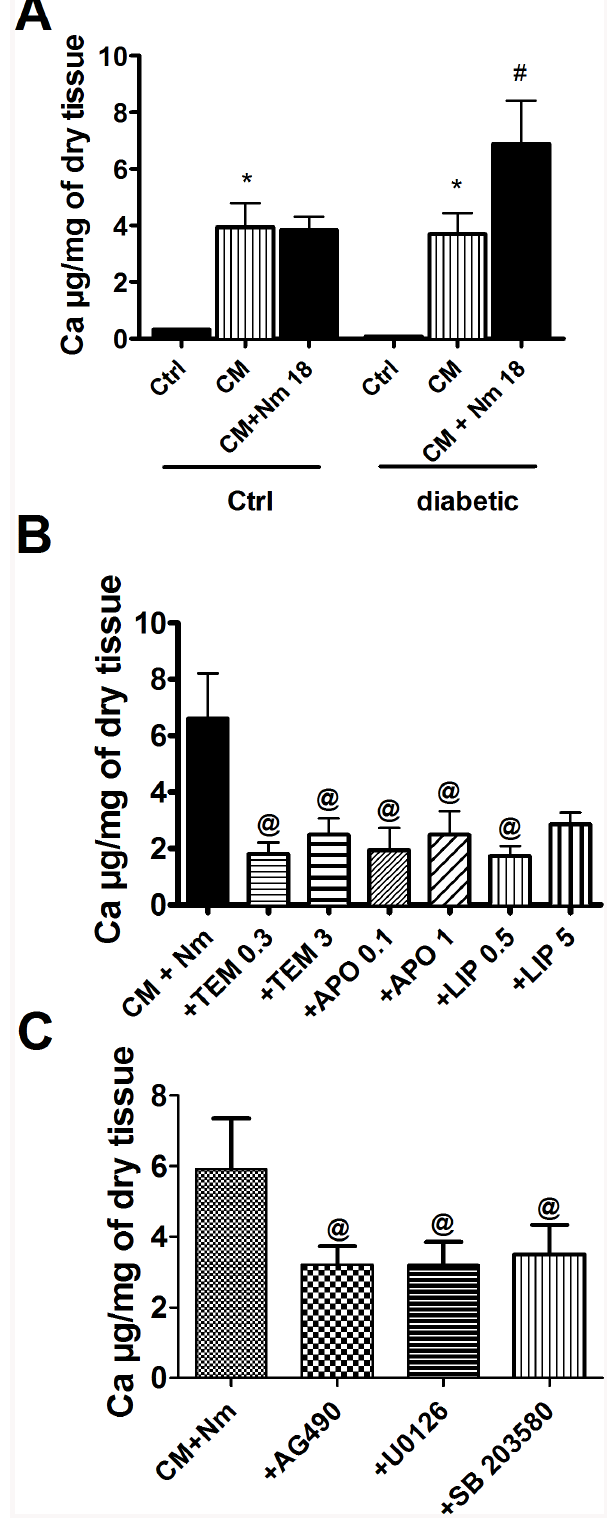
Figure 4. Implication of RAGE signaling pathways in femoral calcification induces by N-methylpyridinium. (A) Ex vivo calcifi- cation of femoral arteries harvested from diabetic and control rats and influence of AGEs receptor stimulation with N-methylpyridinium. CM: calcification medium; N-m 18: N-methylpyridinium 18 m g/mL. (* p , 0.05